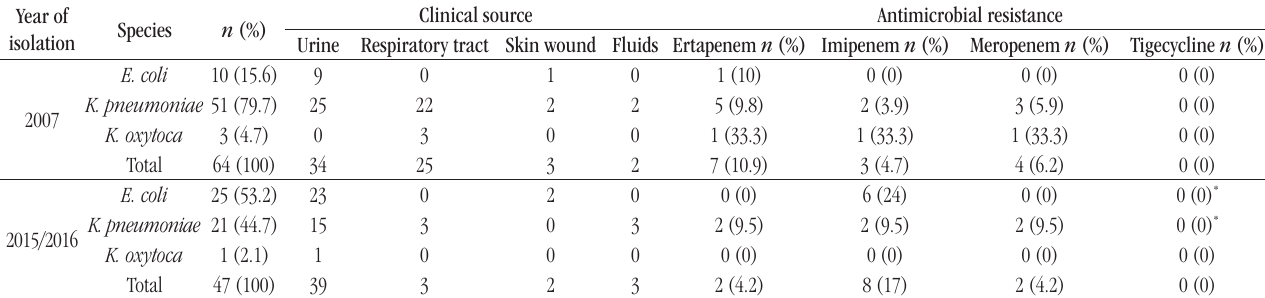
Clinical source Antimicrobial